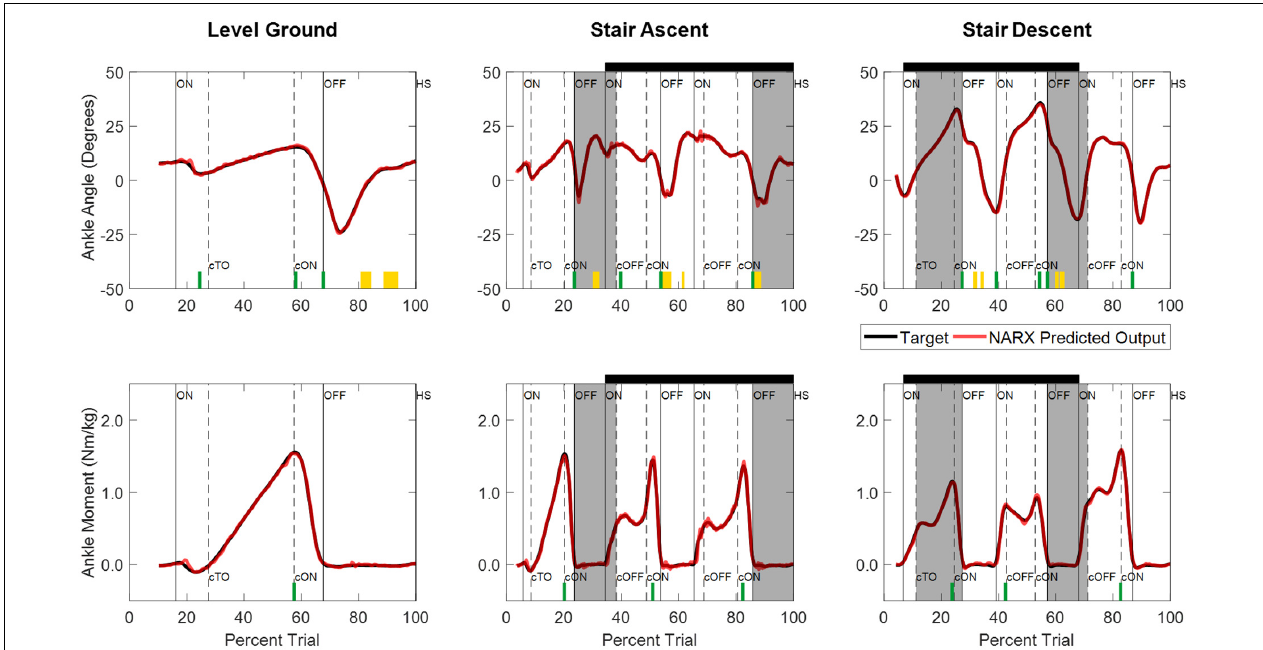
FIGURE 5 | Time series of NARX model prediction of ankle angle and ankle moment for level ground walking, and stair ambulation of a typical participant (S04) using optimal model parameters ( τ : 58 ms, D: 83 ms, N: 6). NARX model predictions are shown for the k-fold novel test trials with the best accuracy across ambulation conditions and model outputs. Critical performance points used to test for statistically significant differences between the model prediction and experimentally measured targets are denoted by yellow blocks (clearance intervals), and green lines (stance points). No significant differences were found across participants (B-H adjusted p > 0.05). Shading and line markers are defined the same as in Figure 3